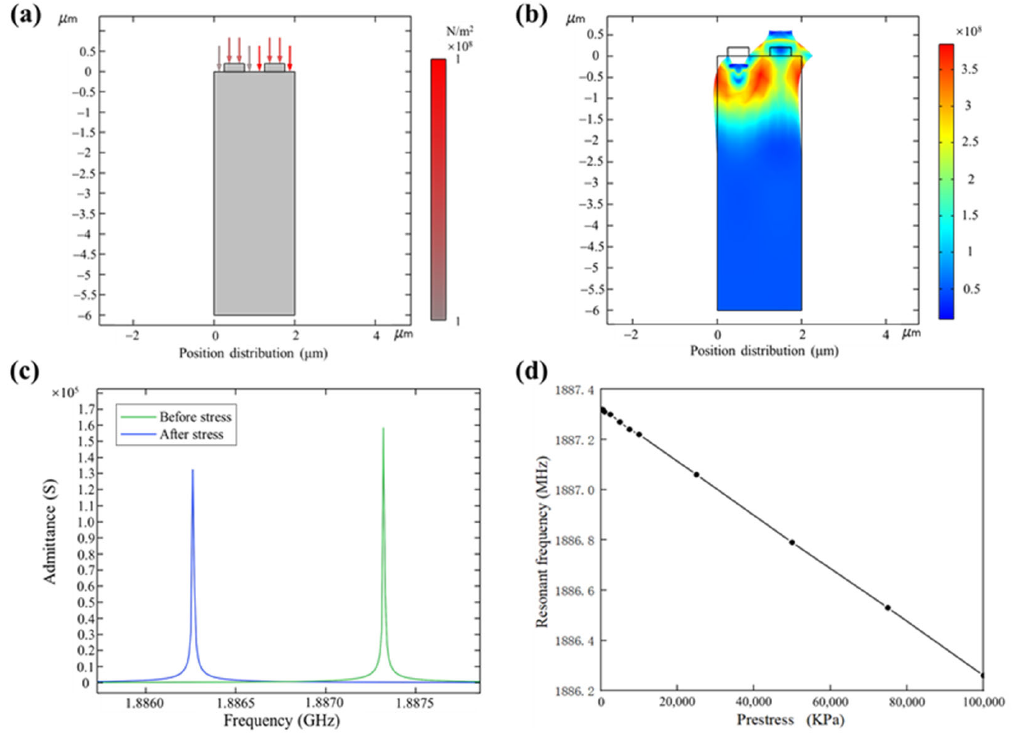
Figure 5. Finite element stress simulation analysis of SAW. ( a ) Schematic diagram of stress applied on the model surface; ( b ) schematic diagram of finite element simulation stress; ( c ) comparison of admittance curves before and after stress application; ( d ) the relationship between stress and the resonant frequency of SAW.